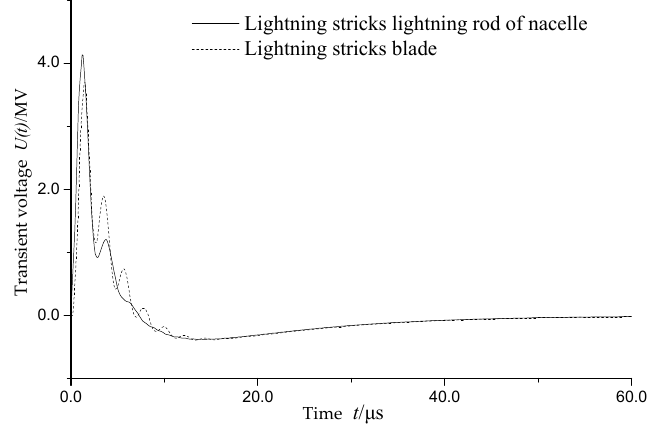
Figure 13. Effect of lightning strike point on the transient potential.